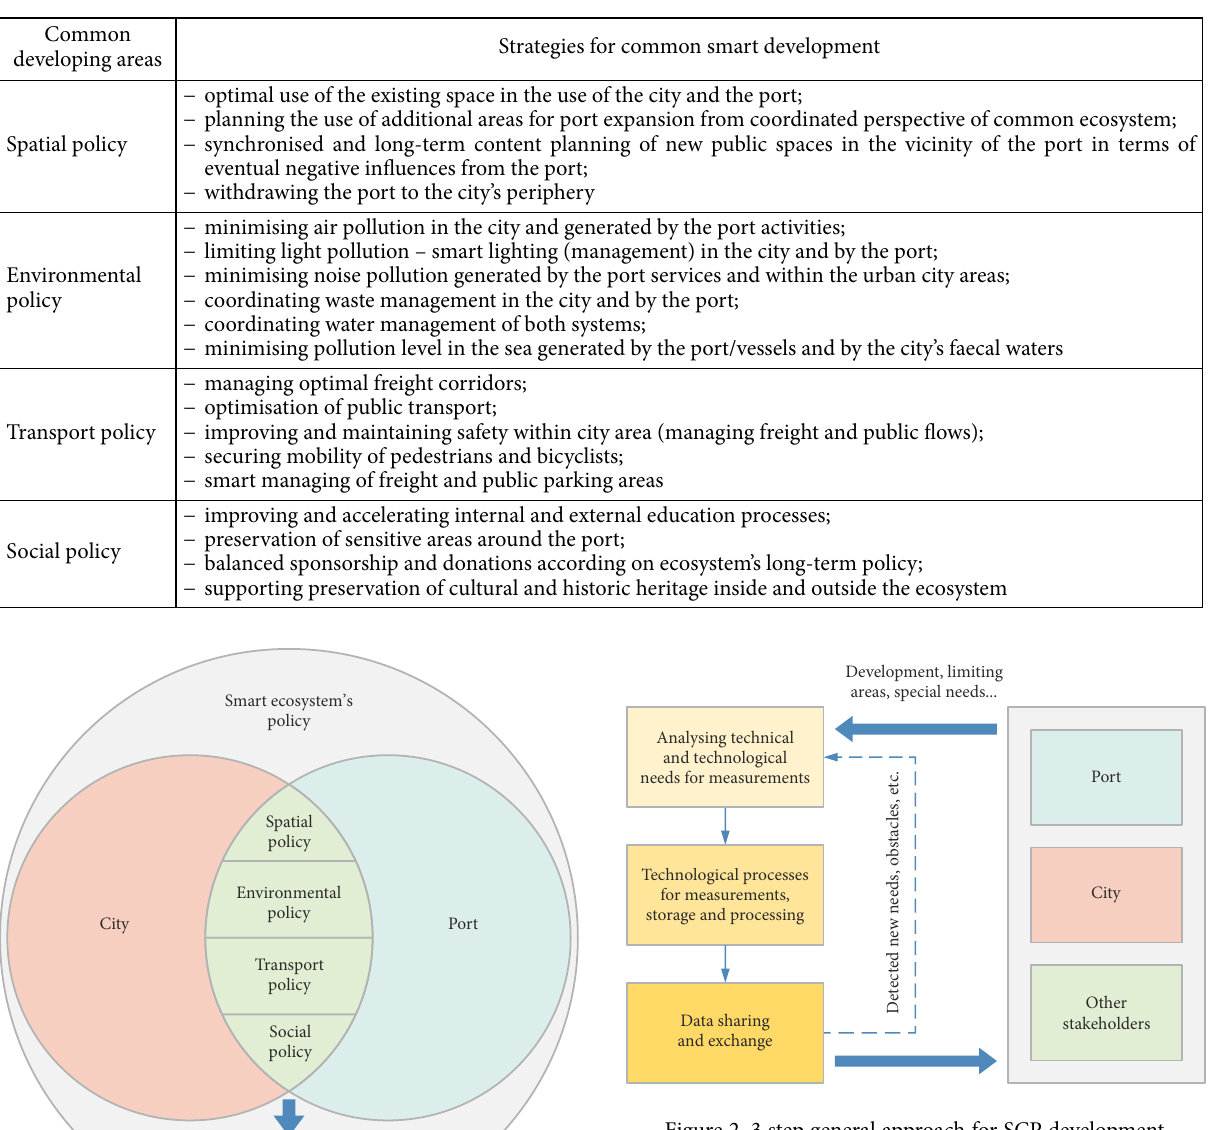
Figure 2. 3 step general approach for SCP